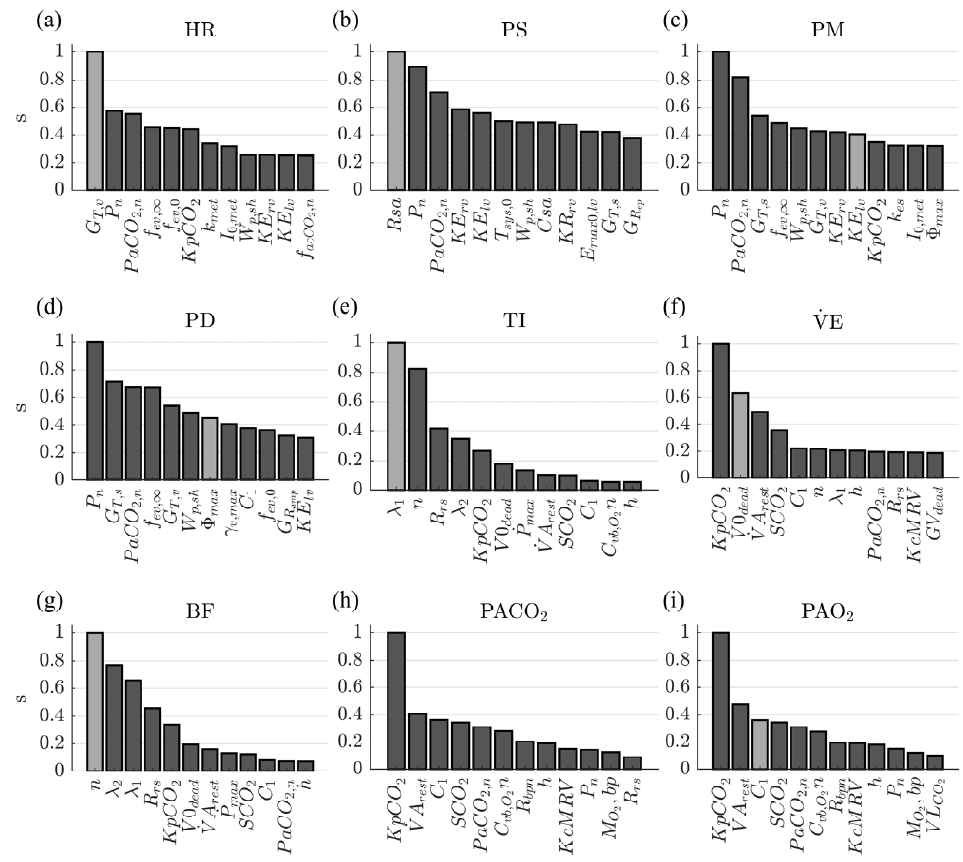
Figure 3. Relative sensitivity rankings after removing the parameters selected for the base fitting approach. The light gray bars correspond to the selected parameters for the specific fitting approach, and the dark gray bars correspond to the parameters that remain fixed at nominal values. The subfigures from ( a ) to ( i ) correspond to the result for each of the variables evaluated.